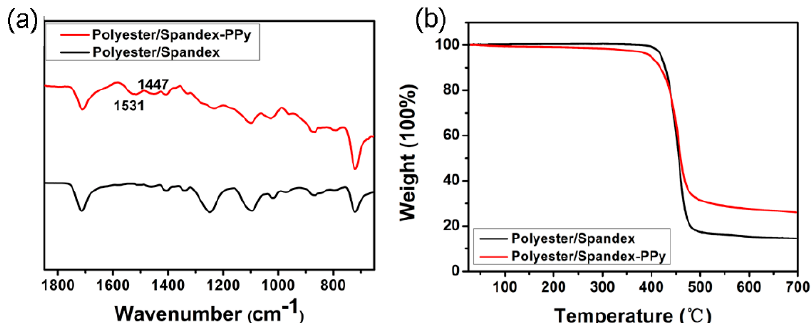
Figure3. ( a )FTIRspectraofthepolyester / spandextextilesbeforeandafterPPymodification. ( b )thermal Figure 3. ( a ) FTIR spectra of the polyester/spandex textiles before and after PPy modification. ( b ) gravimetric analyzer (TGA) curves of the polyester / spandex textiles before and after PPy modification thermal gravimetric analyzer (TGA) curves of the polyester/spandex textiles before and after PPy in an atmosphere of modification in an atmosphere of nitrogen.